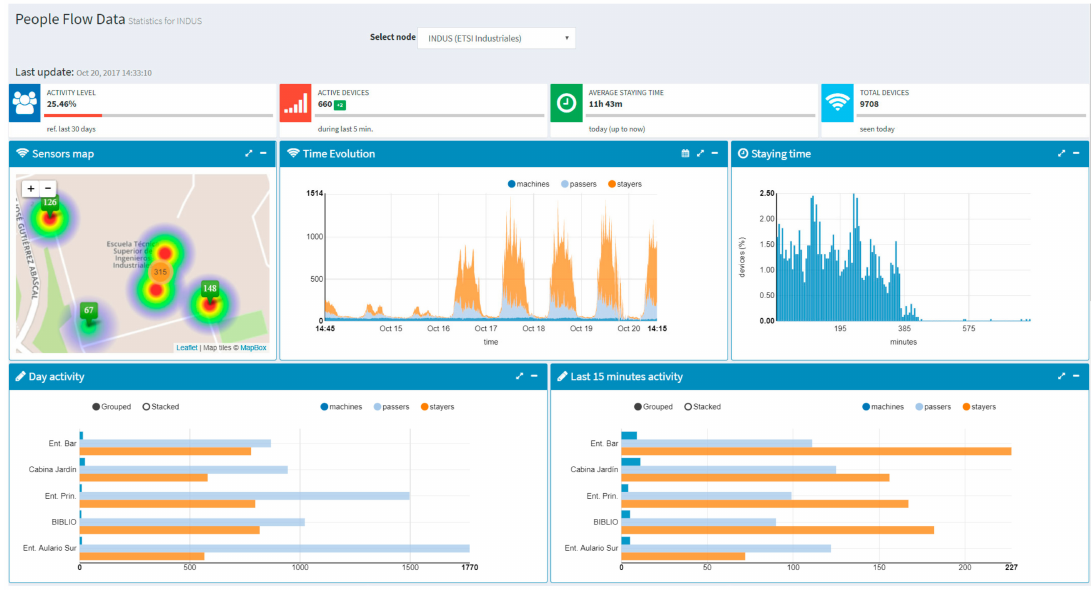
Figure 12. View associated to the people flow monitoring service for the Industrial Engineering School.